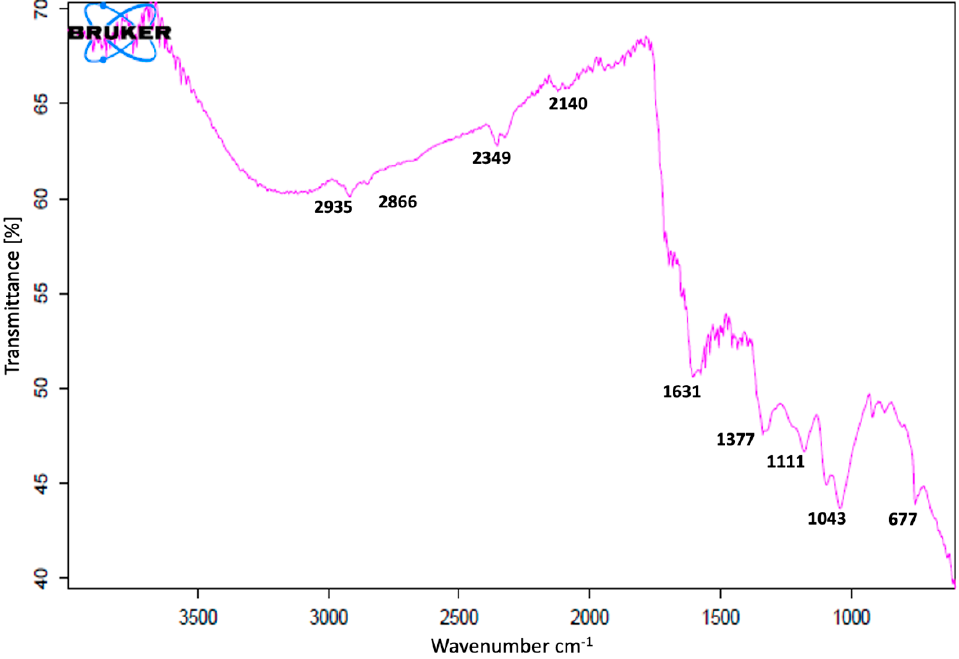
Figure 5. Fourier transform infrared (FT-IR) spectrum of C. guianensis leaf-extract-mediated biosynthesized silver nanoparticles at 25 °C.